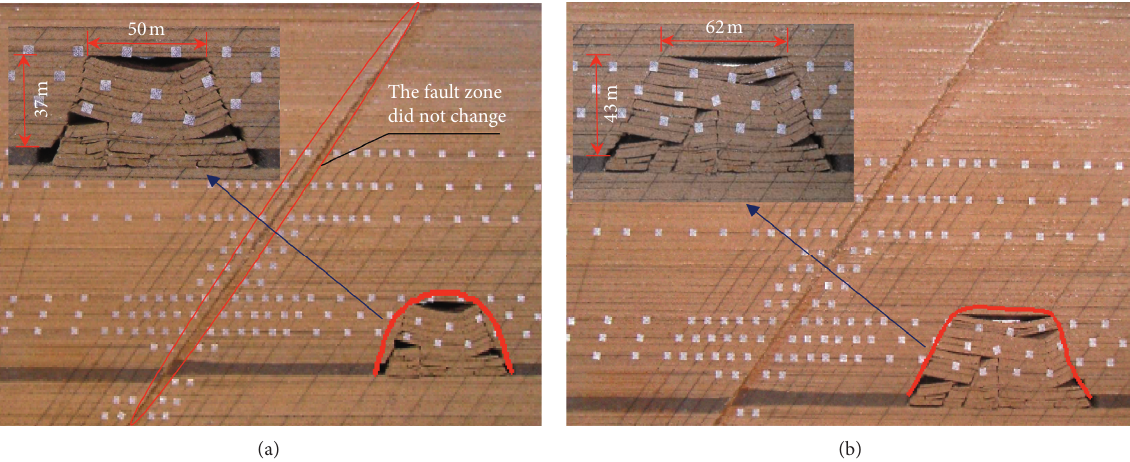
Figure 5: Overburden structure when the working face is 140 m or 110m away from the fault. (a) Distance from the fault, 140m (90m mined). (b) Distance from the fault, 110m.